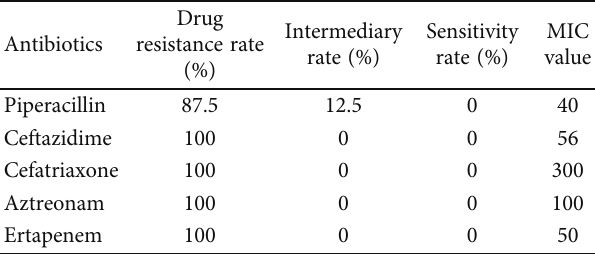
Table 1: Drug sensitivity